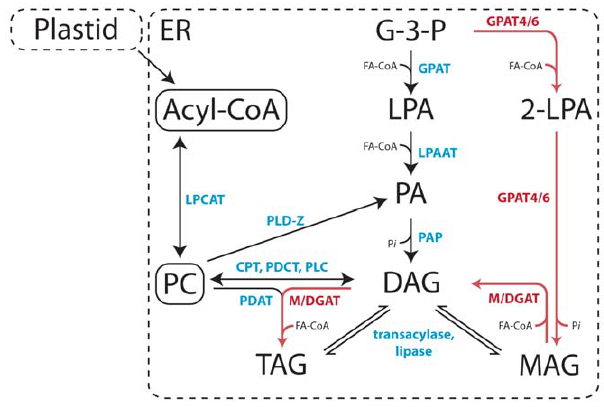
Figure 1. A simplified representation of general lipid metab- olism in plant cells and the concept of the novel transgenic MGAT pathway proposed in this study. The substrates are G-3-P, glycerol-3-phosphate; LPA, lysophosphatidic acid; 2-LPA, sn2 -lysopho- sphatidic acid; PA, phosphatidic acid; MAG, monoacylglycerol; DAG, diacylglycerol; TAG, triacylglycerol; PC, phosphatidylcholine. The enzymes are GPAT, glycerol-3-phosphate acyltransferase; GPAT4/6, denotes enzymes with both GPAT and phosphatase activity such as the A. thaliana GPAT4 and GPAT6; LPAAT, lysophosphatidic acid acyltransferase; PAP, phosphatidic acid phosphatase; MGAT, mono- acylglycerol acyltransferase; DGAT, diacylglycerol acyltransferase; PDAT, phospholipid:diacylglycerol acyltransferase; CPT, CDP-choline:diacylgly- cerol cholinephosphotransferase; PDCT, phosphatidylcholine:diacylgly- cerol cholinephosphotransferase; PLC, phospholipase C; PLD-Z, phos- pholipase D Z-class; LPCAT, lysophosphatidylcholine acyltransferase; Pi, inorganic phosphate.